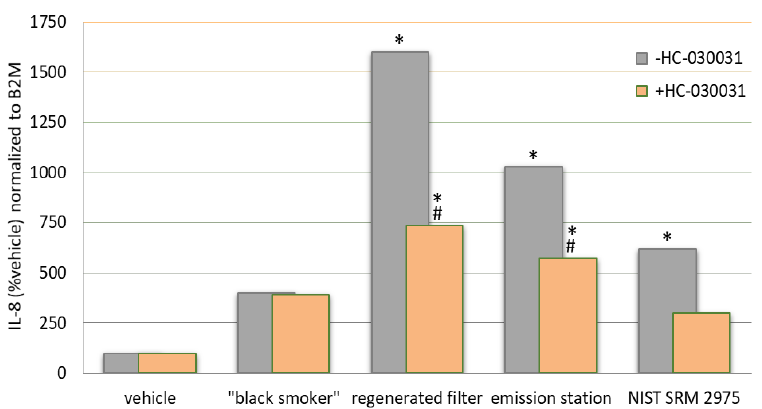
Figure 3. Changes in interleukin 8 (IL-8) mRNA expression as an indicator of inflammation induced by DEP originating from a “black smoker” diesel truck, a diesel exhaust filter regeneration machine, an emission station and NIST SRM 2975. TRPA1 inhibitor HC-030031 reduces the inflammatory effect. The symbols * and # indicate significant induction relative to control and significant inhibition by HC-030031, respectively. Reproduced with permission from [98].